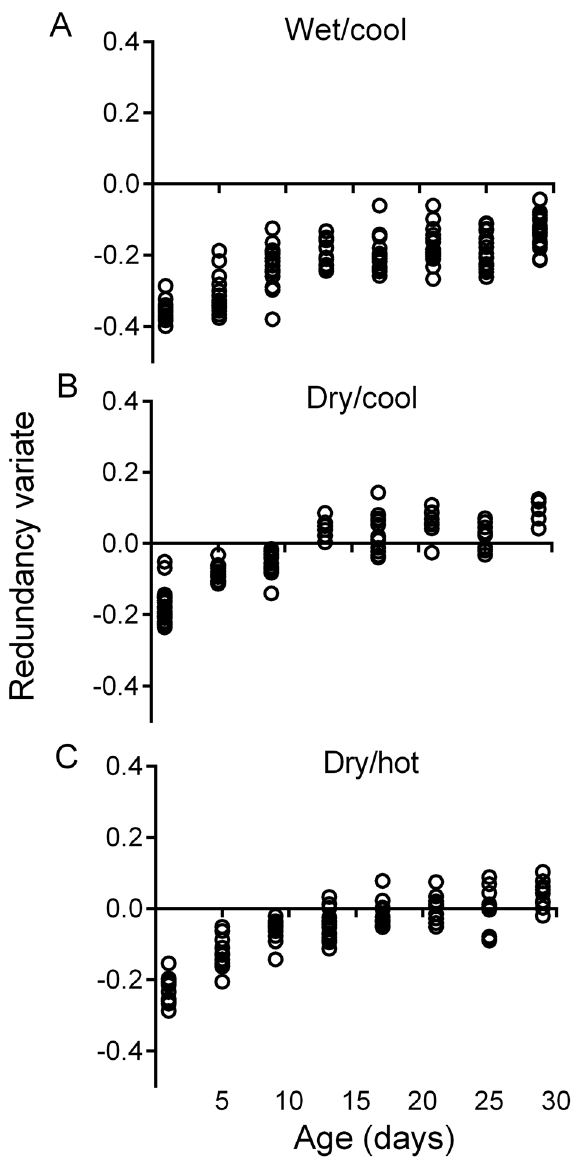
Figure 4. Redundancy variate age prediction models derived from transcriptional scores from Tri Nguyen sentinel cage females. Models were derived from four genes ( AAEL003259 ; Pupal cuticle protein 78E , AAEL007490 ; conserved hypothetical protein , AAEL008844 ; Calcium binding protein , putative , and AAEL014255 ; Aquaporin , putative ). A. wet/cool season (September-December) model. B. dry/cool season (January-April) model. C. dry/hot season (May- August) model.